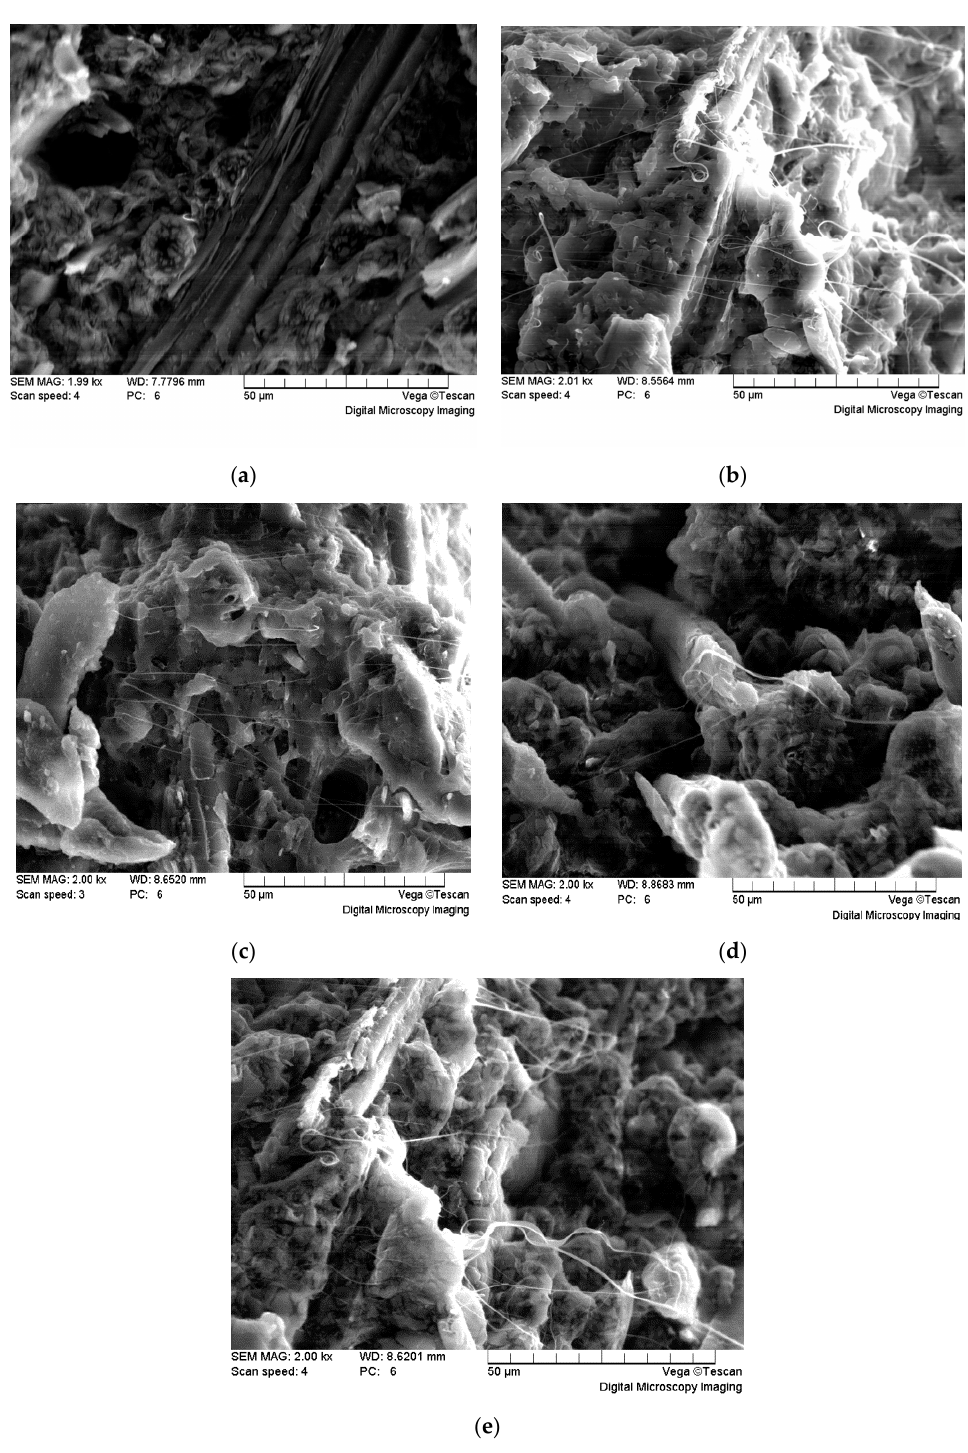
Figure 7. Scanning electron microscopy images (×2000) of PLA/ BF/BF- g -LA impact surfaces ( a ) BF- g -LA, 0 phr; ( b ) BF- g -LA, 2 phr; ( c ) BF- g -LA, 4 phr; ( d ) BF- g -LA, 6 phr; ( e ) BF- g -LA, 8 phr.